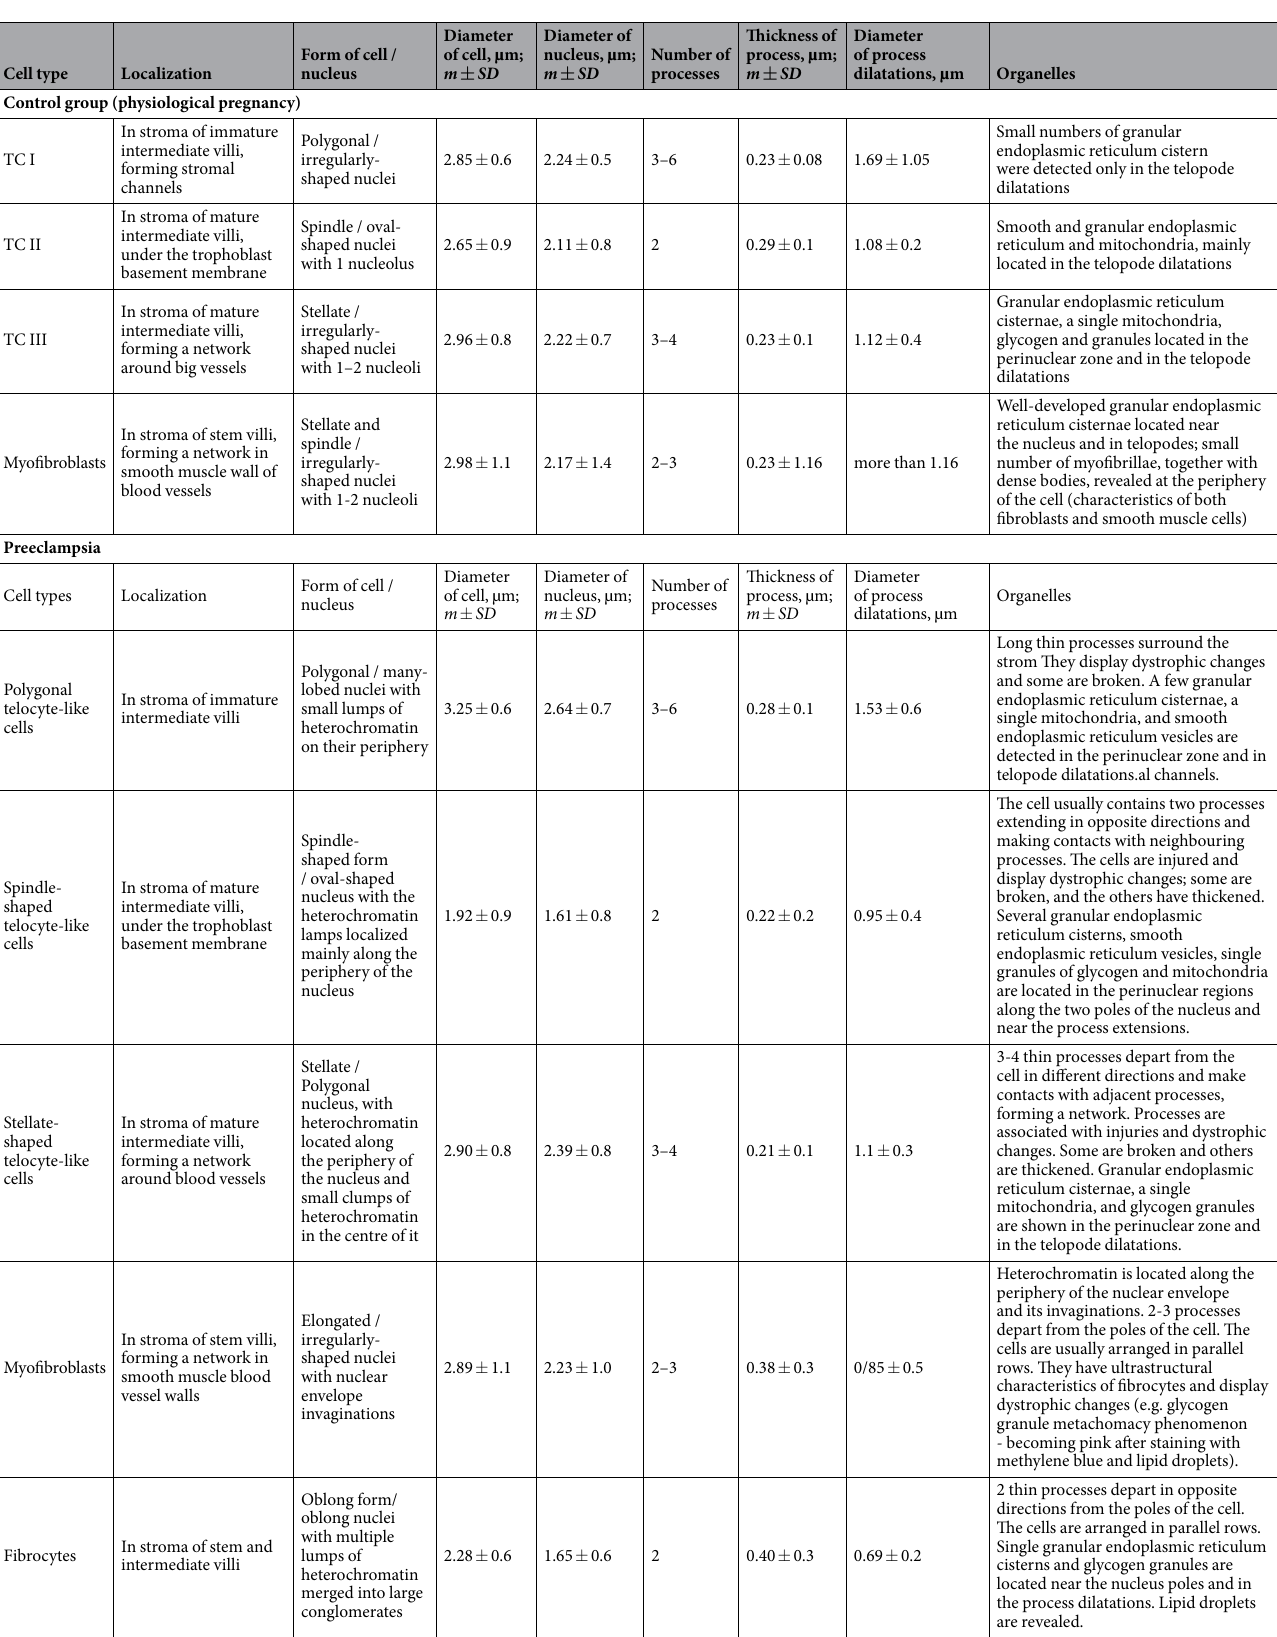
Table 1. Comparison of the ultrastructural features of mesenchyme cells in the. placental villi in